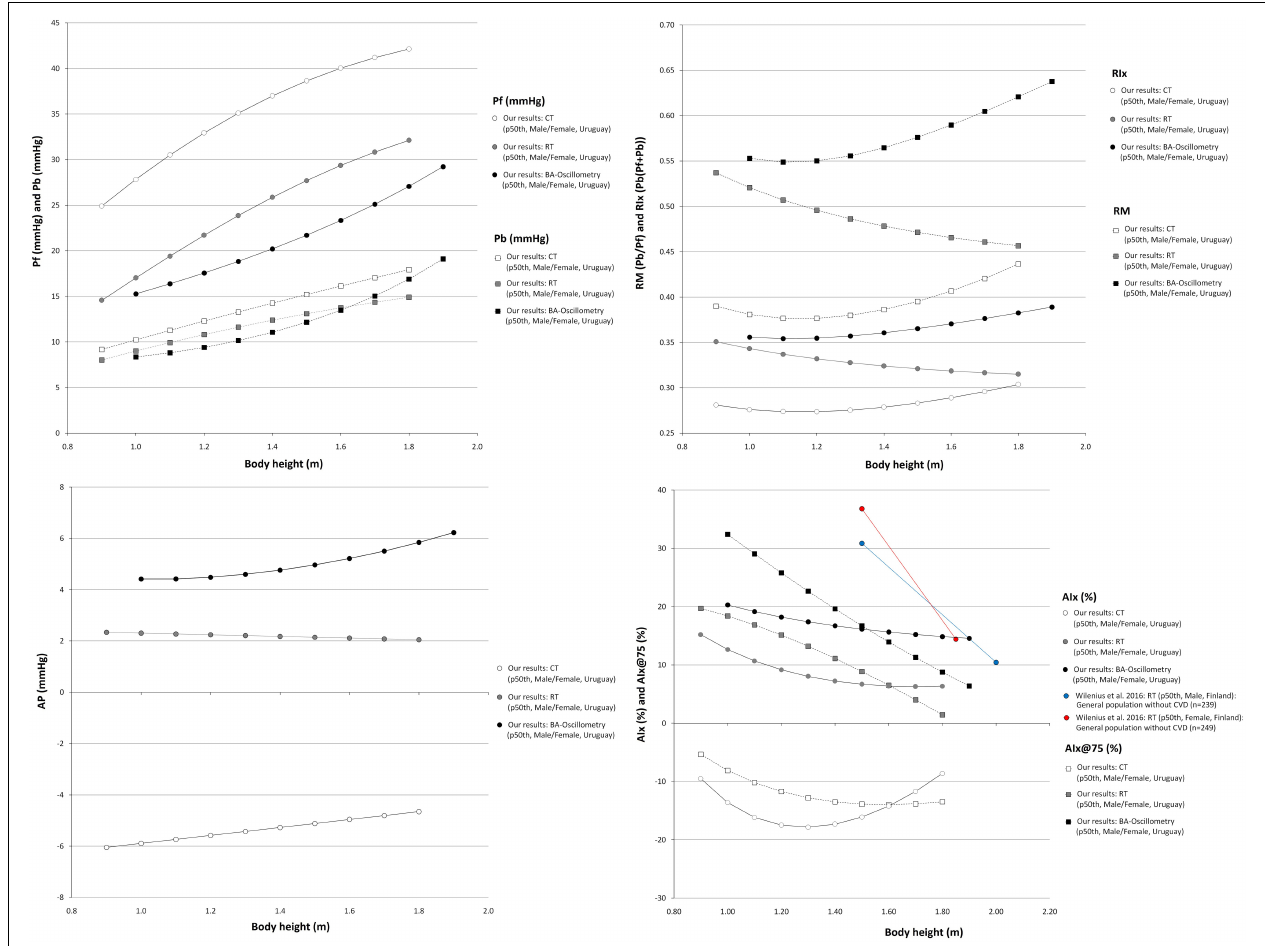
FIGURE 6 | Waveform-derived indexes body height-related profiles. Comparison between curves for waveform derived indexes obtained in our study (p50th) using three different approaches. Pf, Forward pressure; Pb, Backward pressure; RM, Reflection magnitude; RIx, Reflection index; AP, Augmentation pressure; AIx and AIx@75, Augmentation index and heart rate-corrected AIx; CT, carotid applanation tonometry; CVD, cardiovascular disease; RT, radial applanation tonometry; BA, brachial